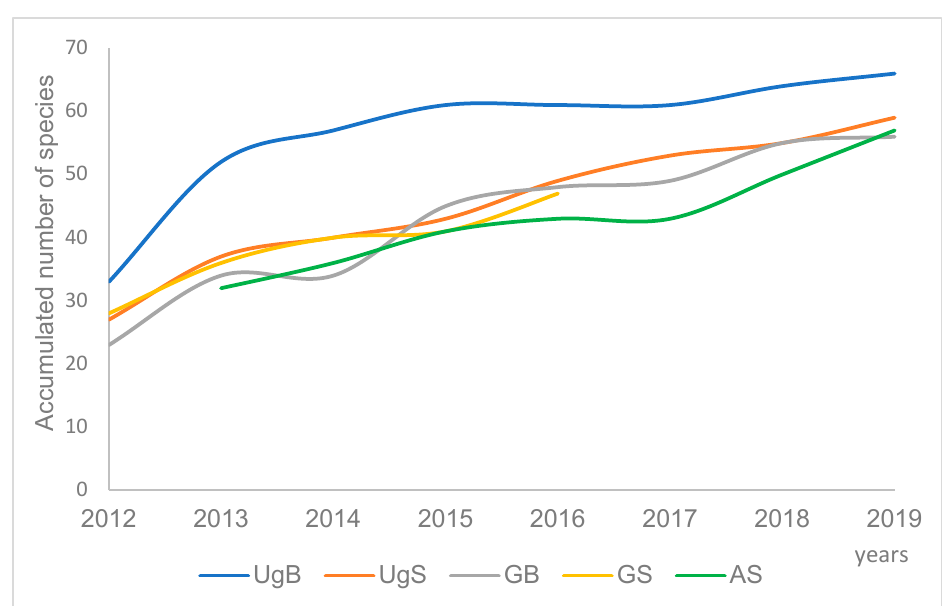
Figure 4. Accumulation of the number of recorded spider species at the monitoring plots during the study period. For the abbreviations, see Table 1.